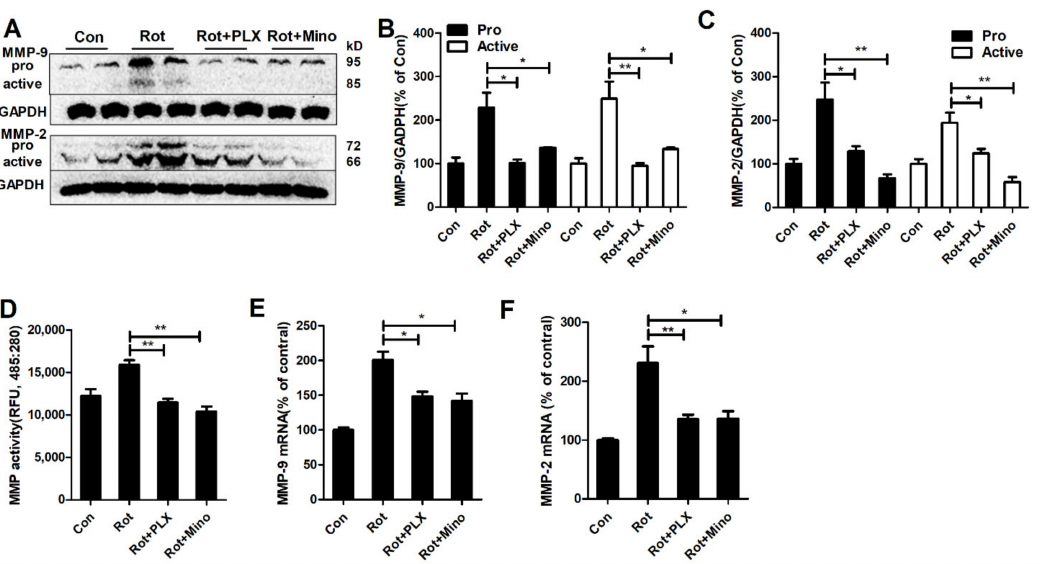
Figure 4. Microglia regulate MMP-2/-9 activation in rotenone-treated mice. ( A ) Representative blots of MMP-2/-9 in mice for each group. ( B , C ) The quantification of density of pro- and active MMP-2/-9 blots. ( D ) The activities of MMP in the midbrain of mice for each group. ( E , F ) Gene expressions of MMP-2/-9 in the midbrain of mice for each group. n = 4–6. * p < 0.05, ** p < 0.01. Con: vehicle-treated mice group; Rot: 1.5 mg/kg/d rotenone-treated mice group; Rot + PLX: 1.5 mg/kg/d rotenone + PLX3397-treated mice group; Rot + Mino: 1.5 mg/kg/d rotenone + minocycline-treated mice group.